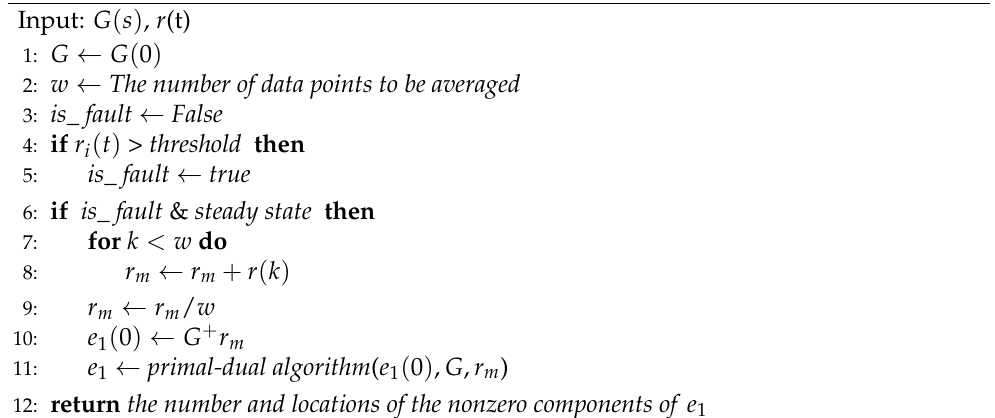
Algorithm 2 Fault isolation with the minimal (cid:96) 1 -norm